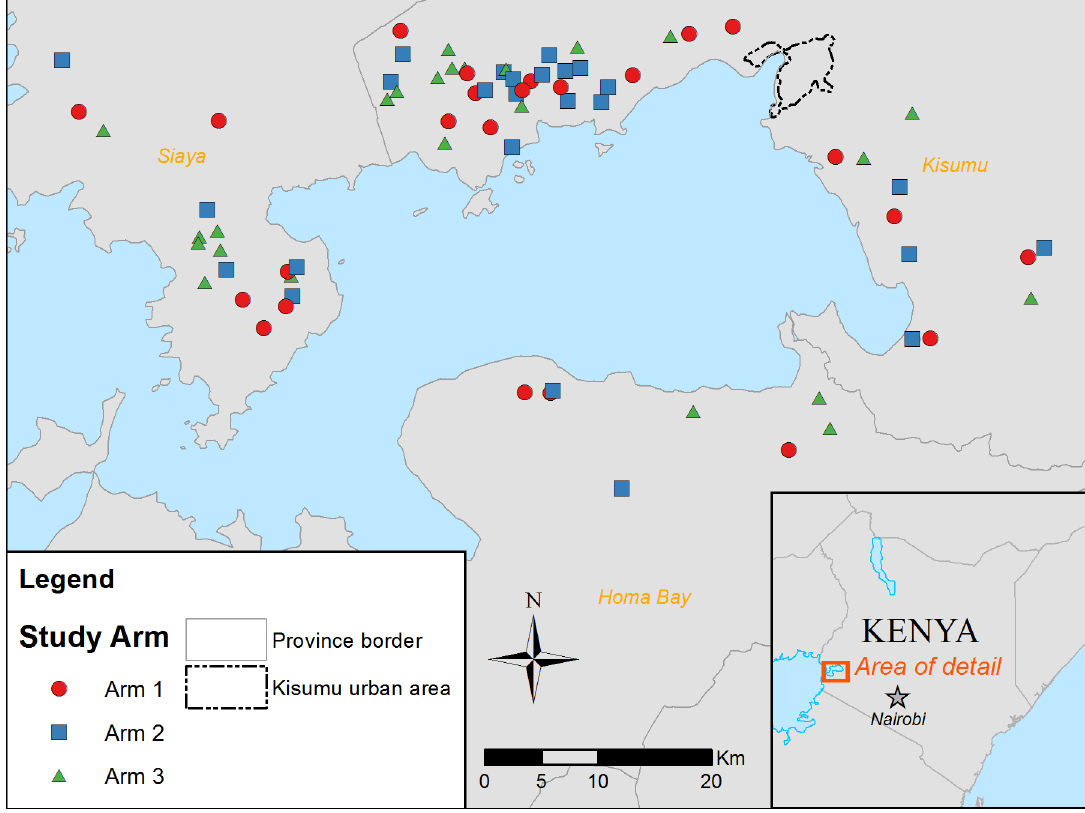
Fig 2. Location of schools included in study by arm, Western Kenya (n = 25 per arm). Map was created with ArcGIS (version 10.3, ESRI, Inc., Redlands,CA) using layers from ESRI data and Maps